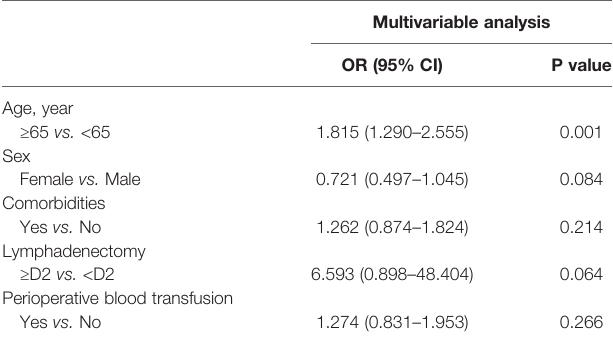
TABLE 2 | Multivariable logistic regression analysis of risk factors for severe postoperative